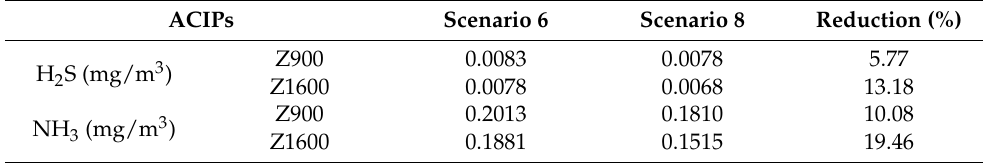
Table 9. The ACIPs with an all-air air-conditioning system in different scenarios.